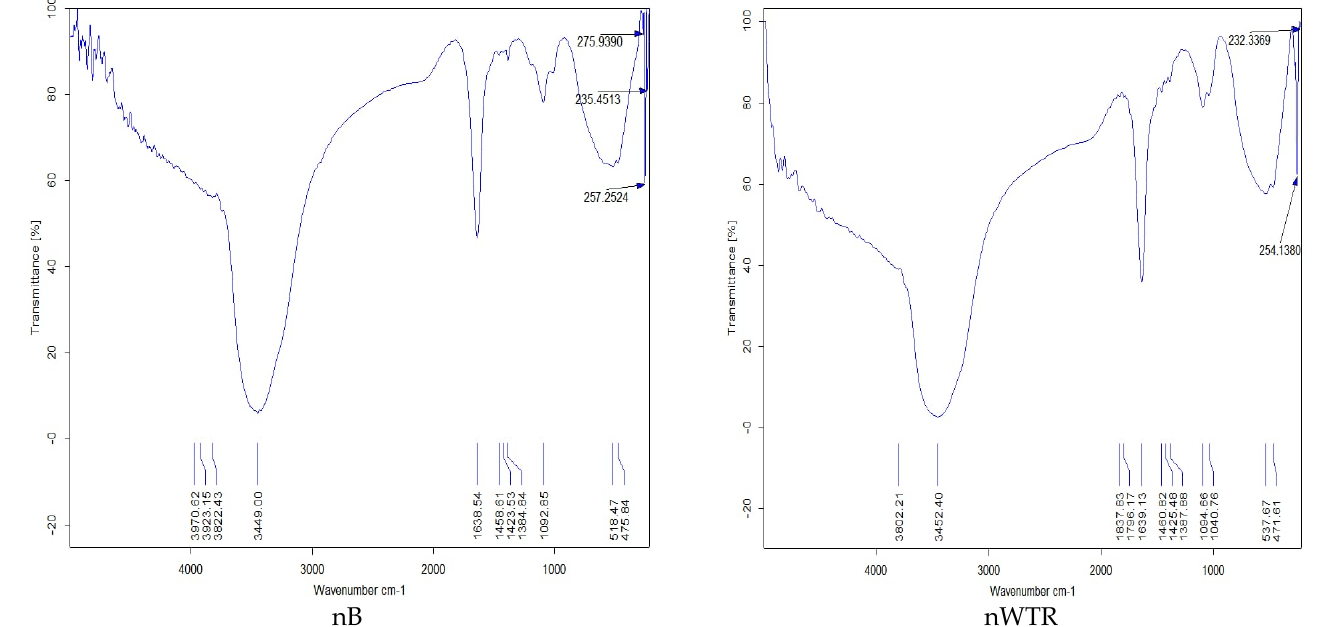
Figure 1. Fourier-transform infrared (FTIR) for nanobiochar (nB) and nanowater treatment residuals (nWTR).